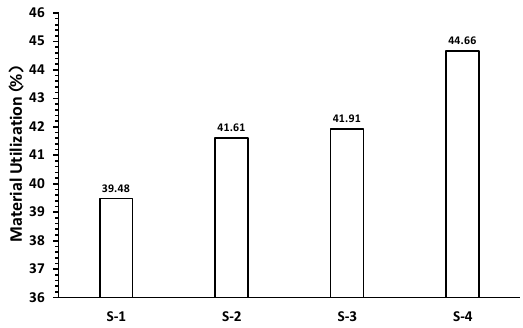
Figure 7. Material utilisation calculated using (1) for S-1–S-4 configurations.